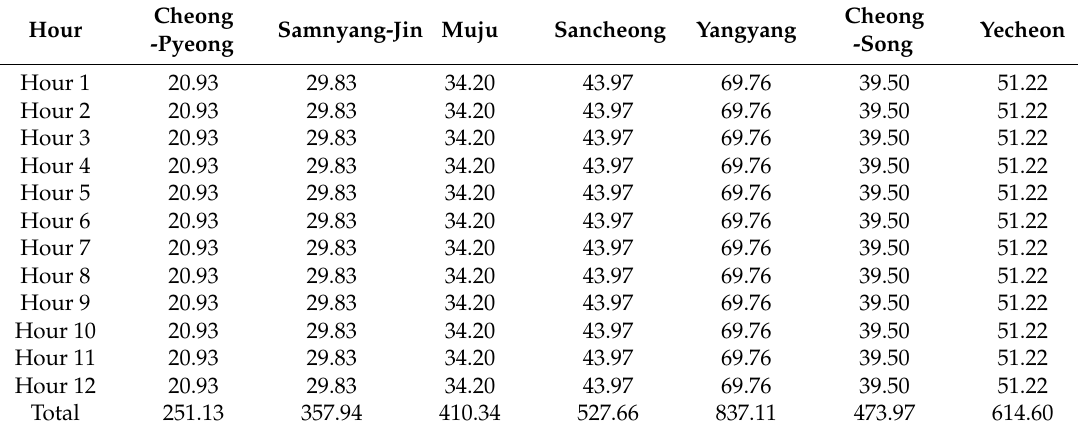
Table 2. PHES hourly reserve capacity. 10% of the maximum available energy is allocated based on the uniform allocation method (unit: